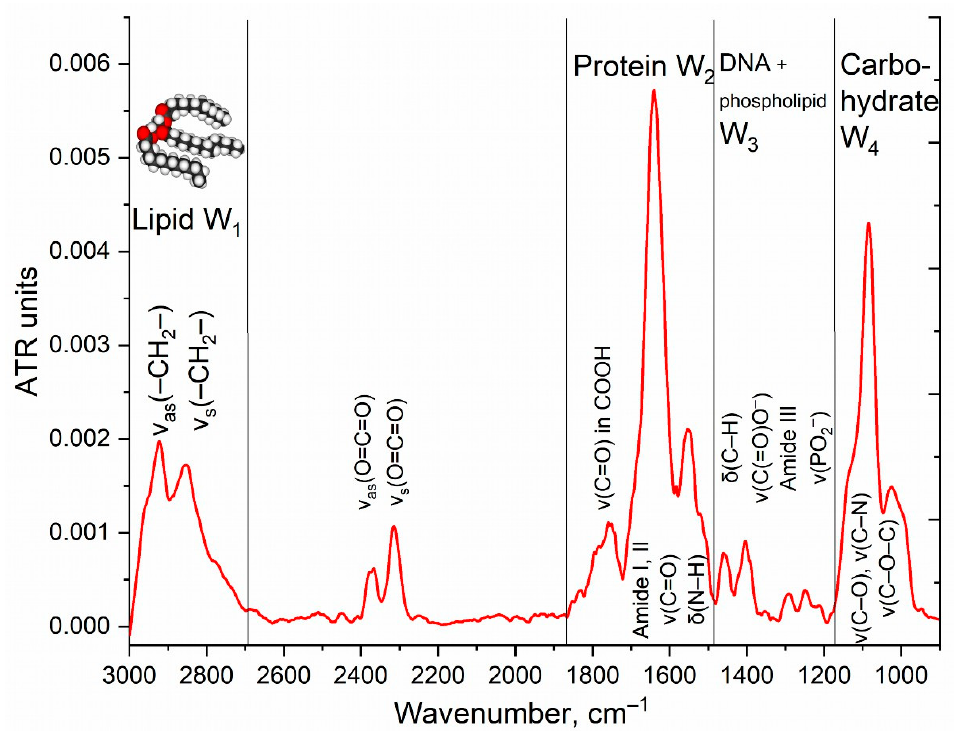
Figure 1. FTIR spectra of E. coli cells suspension in water. T = 22 °C.